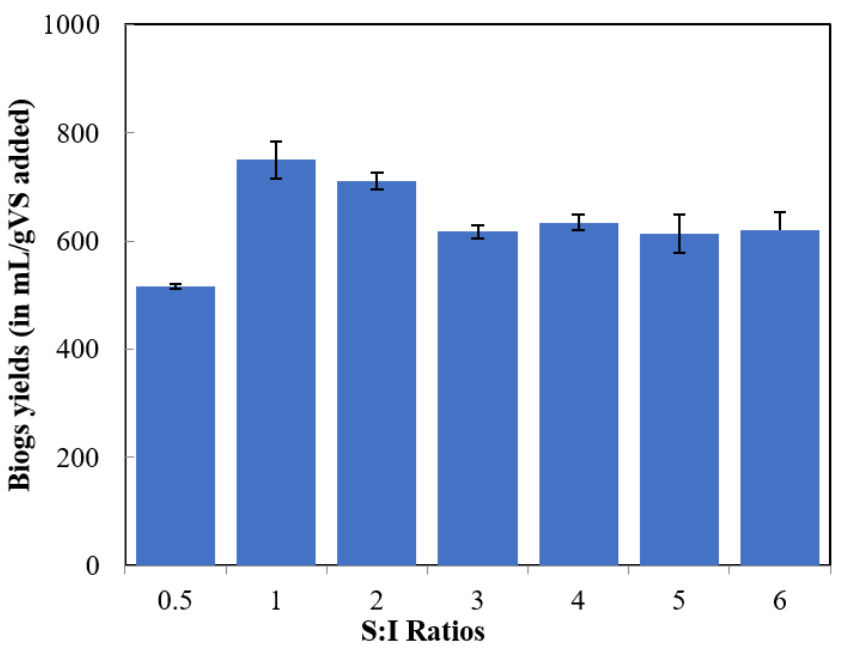
Figure 1. Biogas (Carbon dioxide scrubbed) yields per g volatile solids (VS) of food waste (FW) added at different S:I (Substrate: Inoculum) ratios. Table 2. VS removal efficiencies and end pH change in tests with different S:I